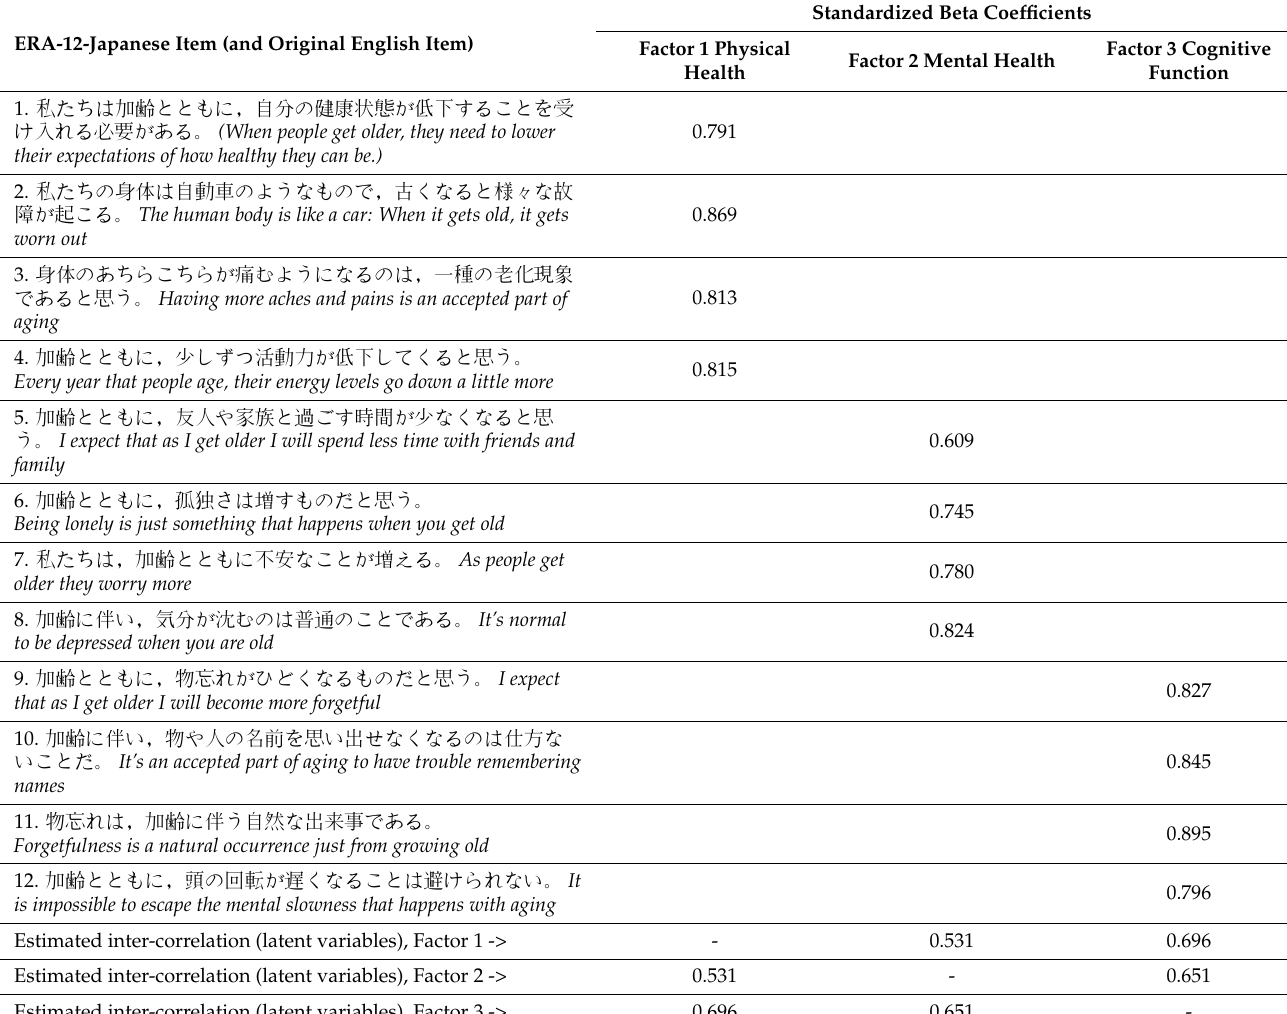
Table 3. Results of CFA with middle-aged and older adult Japanese (N =